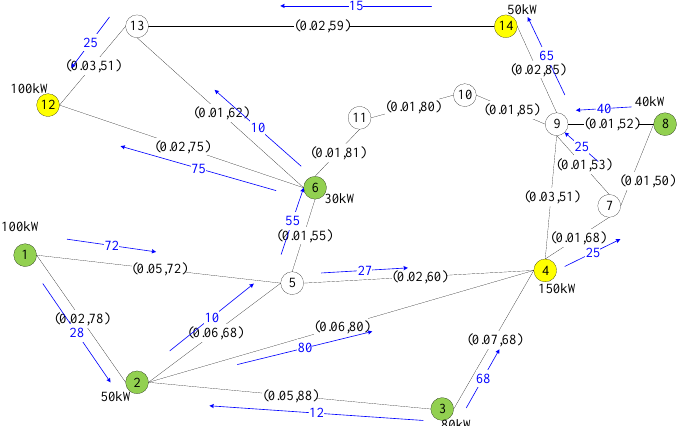
Figure 9. Optimal path selection and source-load matching on the IEEE14 bus.